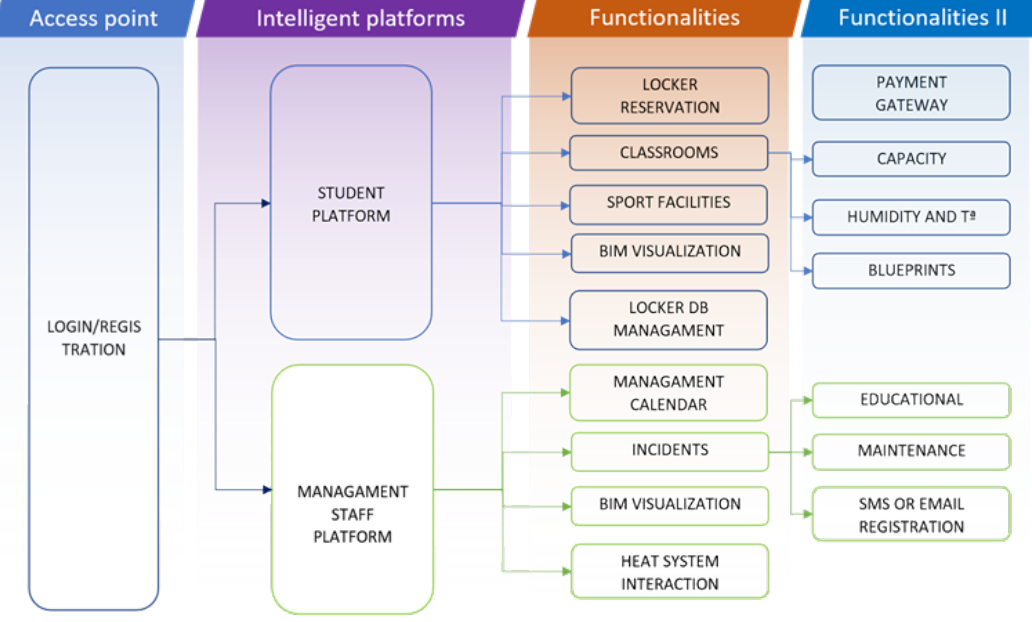
Figure 7. Intelligent platform functionalities.